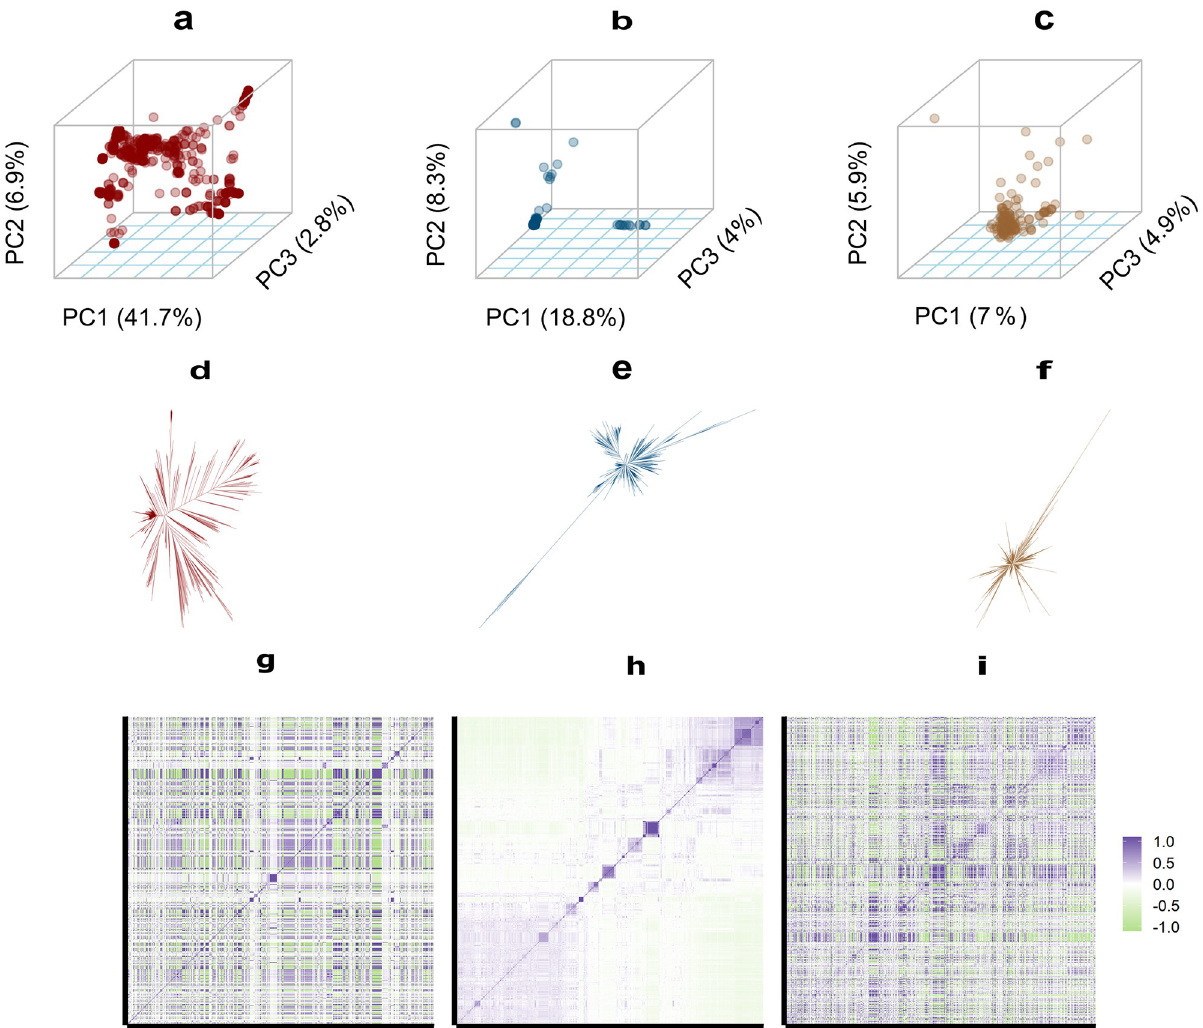
Fig 1. Principal components analysis, neighbor-joining trees and heatmaps of genetic covariance matrices. Panels a , b and c represent principal component (PC) analysis for all common SNPs, pan-genomic ORFs, and the copy numbers of pan-genomic ORFs on 787 diploid S. cerevisiae isolates, respectively. PC1, PC2, and PC3 denote the first three principal components. Panels d , e and f represent the neighbor-joining trees of 787 diploid S. cerevisiae constructed using the three types of dataset. Panels g , h and i display heatmaps of genetic covariance matrices of 787 diploid S. cerevisiae isolates based on all common SNPs, pan-genomic open reading frames, and copy numbers of pan-genomic open reading frames, respectively. Isolates are in the same order in all three